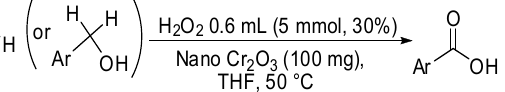
Fig. 5. XRD pattern of the Cr